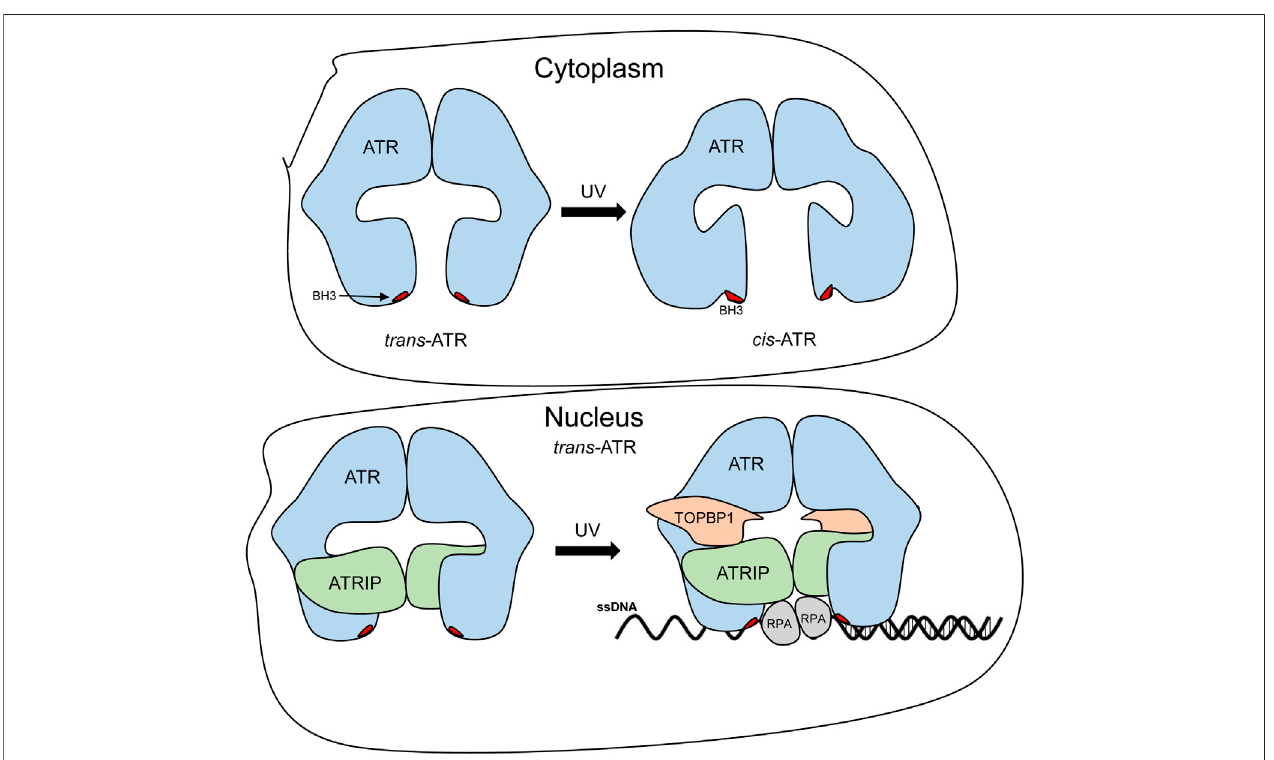
FIGURE 6 | Proposed prolyl isomerization-mediated conformational changes and subcellular compartment-speci fi c functions of ATR. Mass footprinting revealed changesinthesurfacetopologyofATRinthecytoplasmandthenucleus.AfterUVirradiation,cytoplasmicATRundergoesmultipleconformationalchangesthatopenup the BH3 domain and allow tBid – ATR interaction, whereas, in the nucleus, UV irradiation enhances the ATR – ATRIP association, which may help retain the trans- ATR conformation and allow the ATR – ATRIP complex to interact with RPA-bound ss-DNA and the subsequent binding of other ATR activators (like TOPBP1), further enhancing ATR kinase